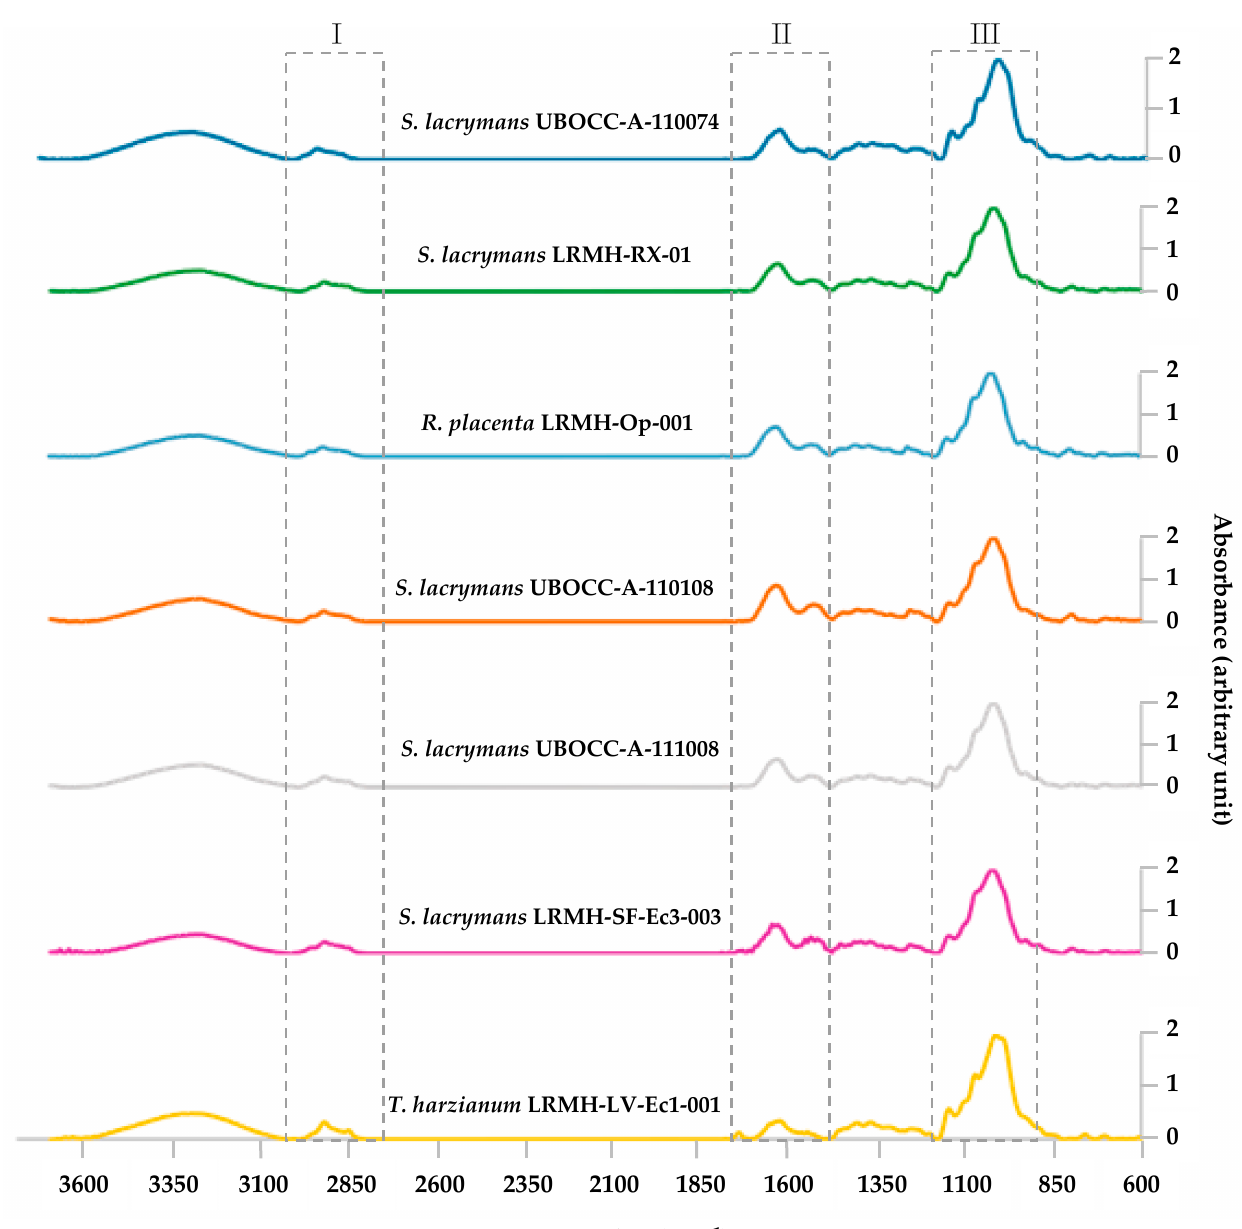
Figure 1. Fourier transform infrared (FTIR) spectra of fungi obtained after growth in liquid medium and min–max normalisation. Characteristic spectral ranges corresponding to major macromolecules are indicated by dotted boxes (I, fatty acids; II, proteins; III, polysaccharides and nucleic acids). Each spectrum is the average of at least five spectra obtained after repeating independent experiments under identical conditions.